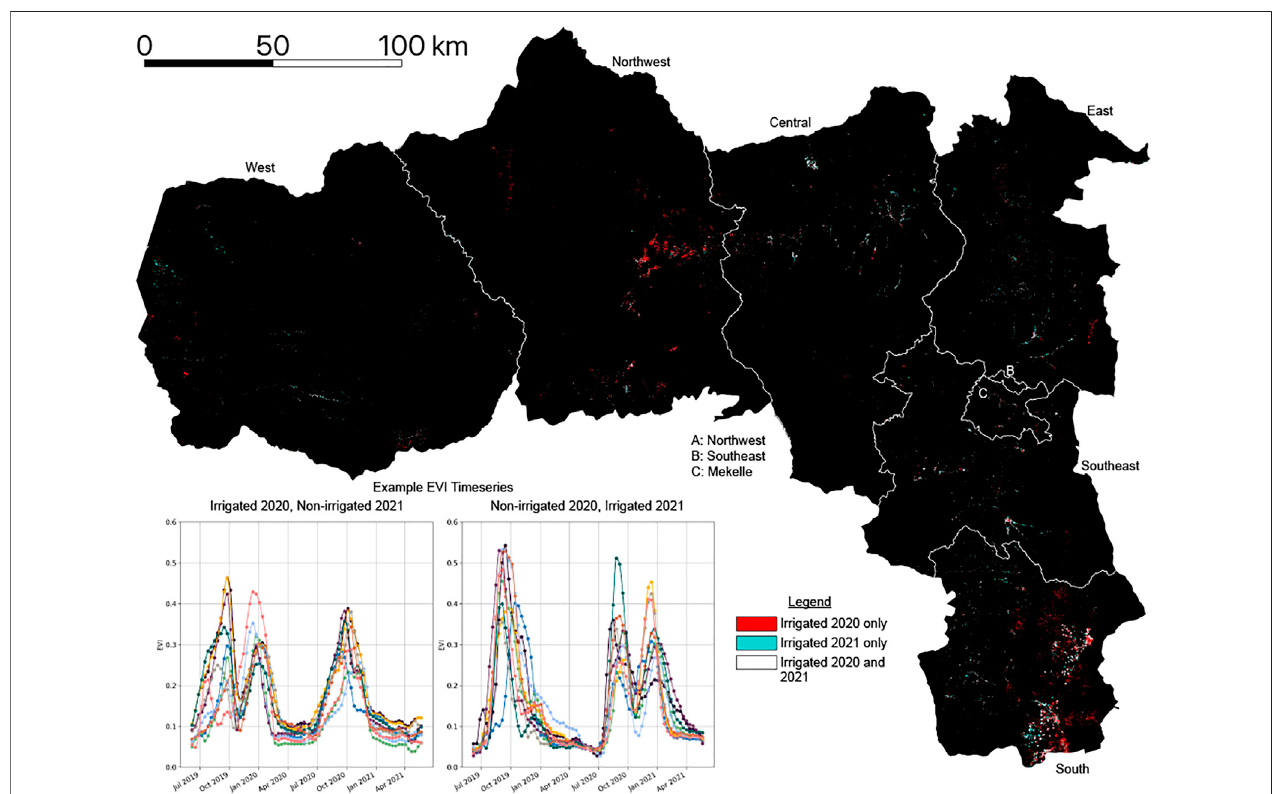
FIGURE 7 | Bitemporal irrigation map for Tigray. Figure inset contains exampleEVI timeseries predicted asirrigated in either 2020 or 2021. A predominance of red indicates that many parts of Tigray contain irrigation detected in 2020 but not in 2021.